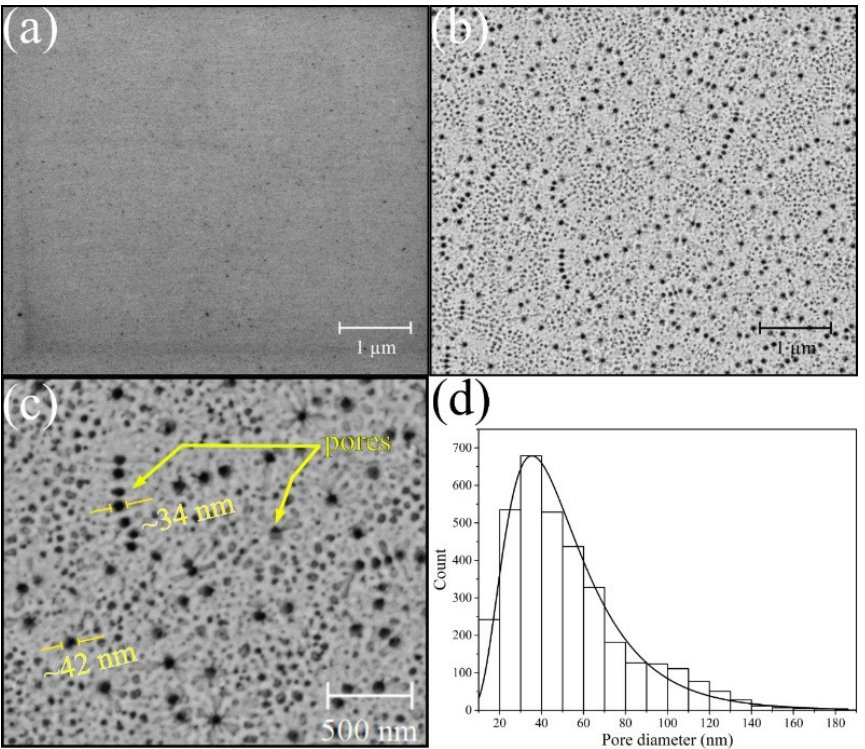
Figure 2. Electron micrographs of ( a ) as-received GaN, ( b ) porous GaN, ( c ) magnified view of porous GaN, and ( d ) pore diameter distribution of porous GaN.